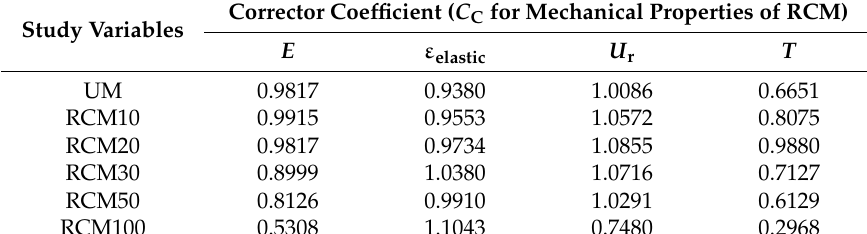
Table 5. C C values for application in PE r equations of the RCM.